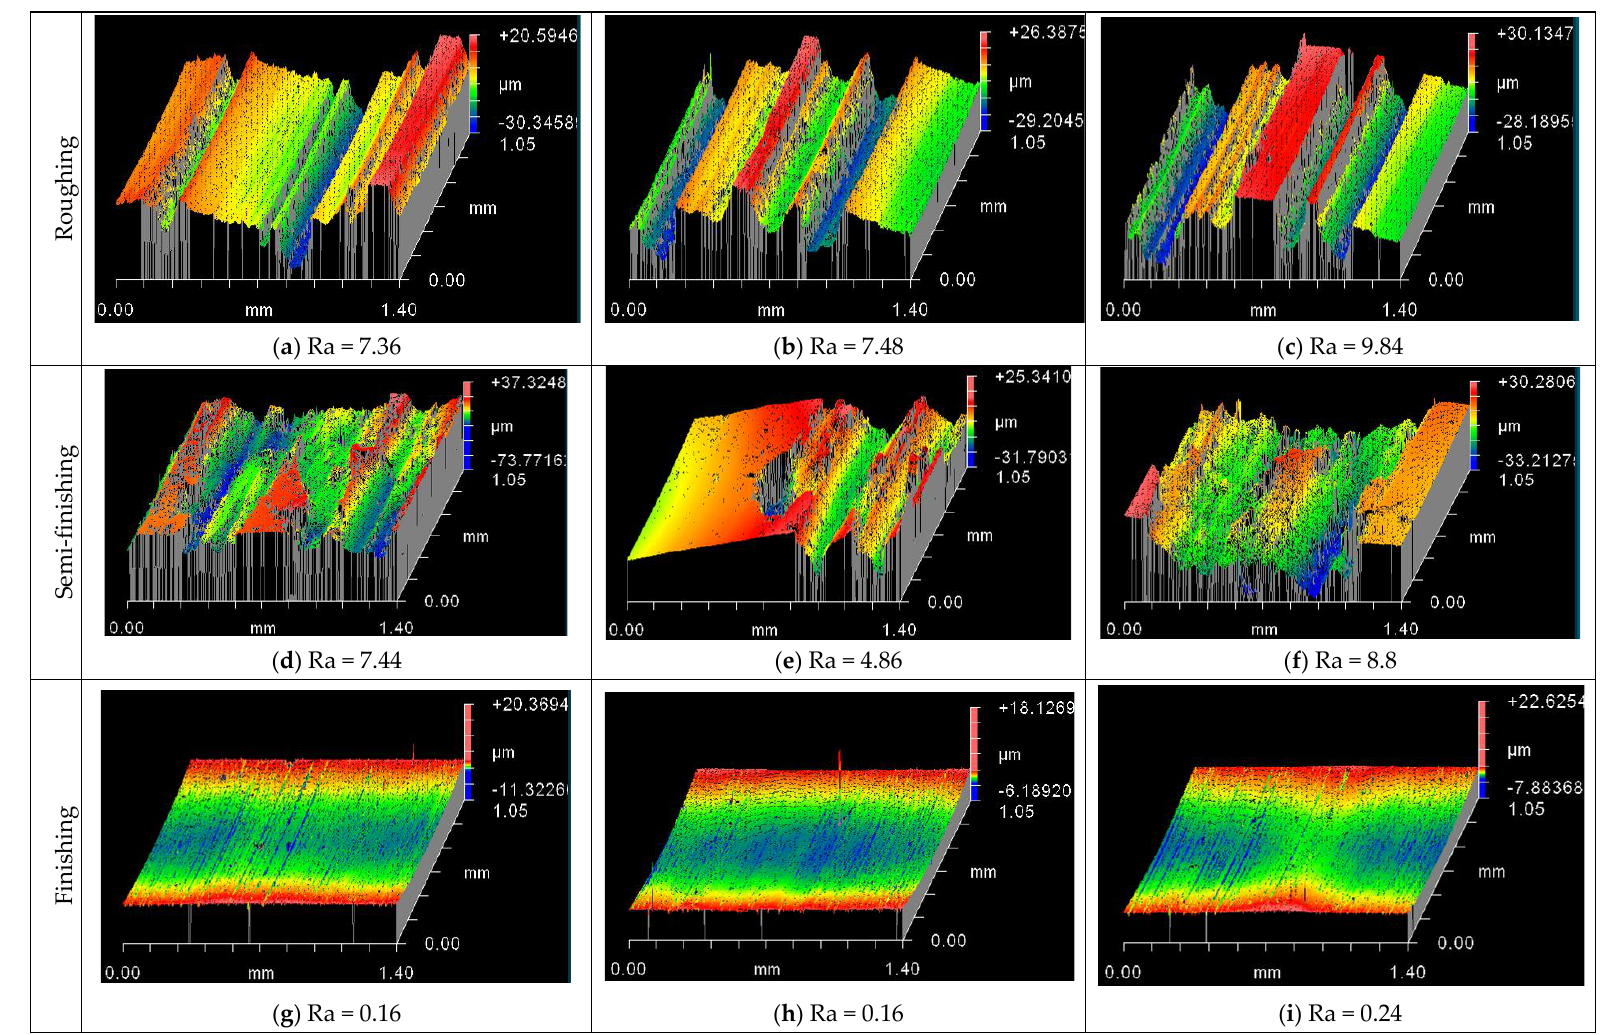
Figure 4. 3D-photos of test specimen surfaces (1.4 × 1.5 mm).